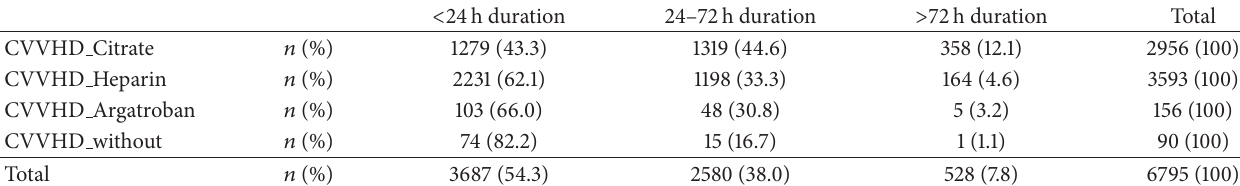
Table 3: Duration of CVVHD filter lifetime dependent on anticoagulation strategy.